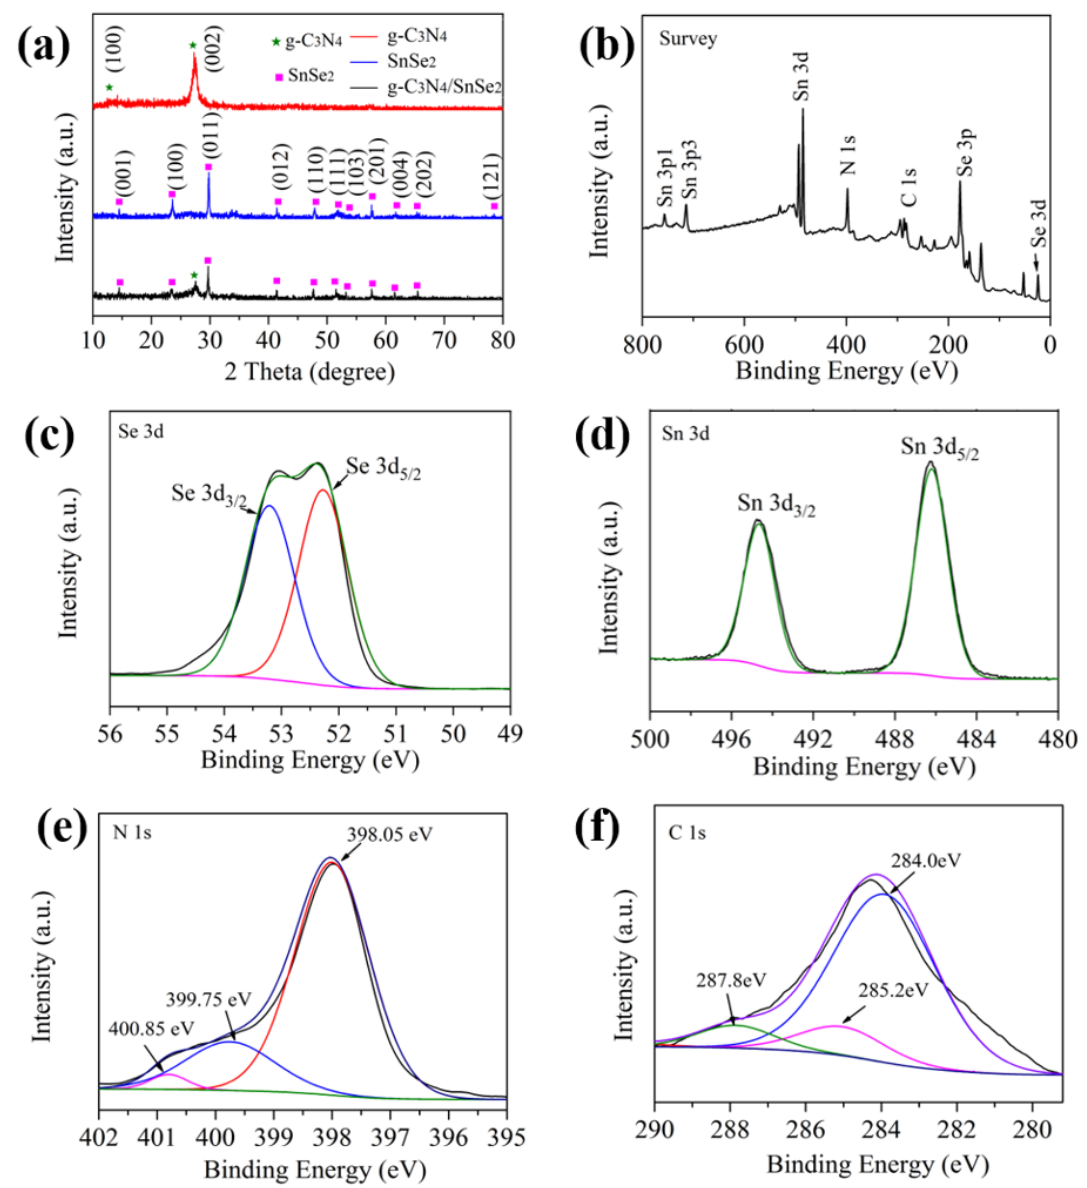
Figure 4. ( a ) XRD patterns of g-C 3 N 4 , SnSe 2 and g-C 3 N 4 /SnSe 2 . XPS spectra of g-C 3 N 4 /SnSe 2 product: ( b ) full spectrum, ( c ) Se 3d, ( d ) Sn 3d, ( e ) N 1s and ( f ) C 1s. product: ( b ) full spectrum, ( c ) Se 3d, ( d ) Sn 3d, ( e ) N 1s and ( f ) C